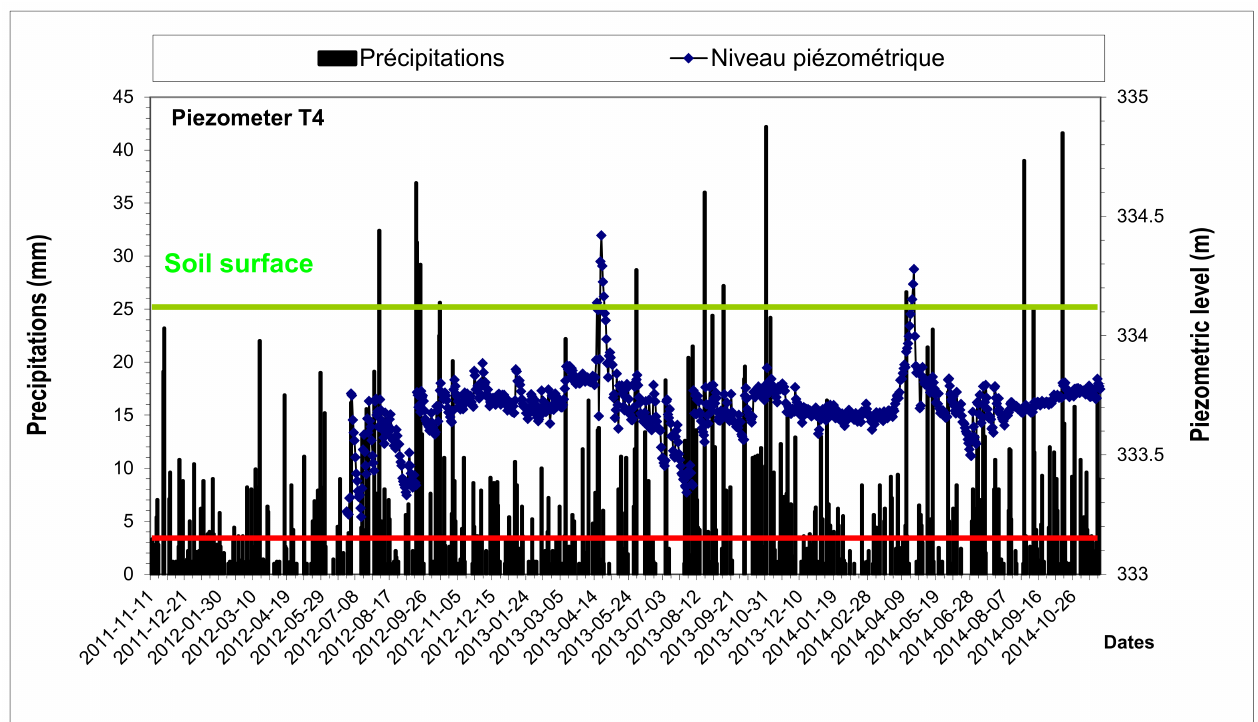
Figure 4. Continuous piezometric level measurements at observation well